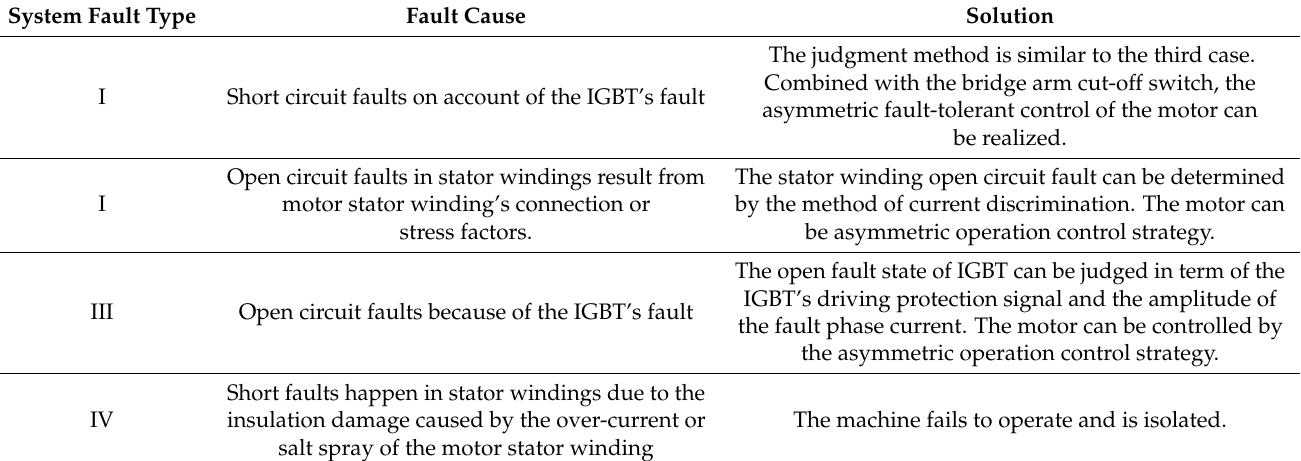
Table 1. Corresponding Treatment Methods about the System of 6P-PMS and Inverter. System Fault Type Fault Cause Solution The judgment method is similar to the third case. Combined with the bridge arm cut-off switch, the I Short circuit faults on account of the IGBT’s fault asymmetric fault-tolerant control of the motor can be realized. The stator winding open circuit fault can be determined by the method of current discrimination. The motor can stress factors. be asymmetric operation control